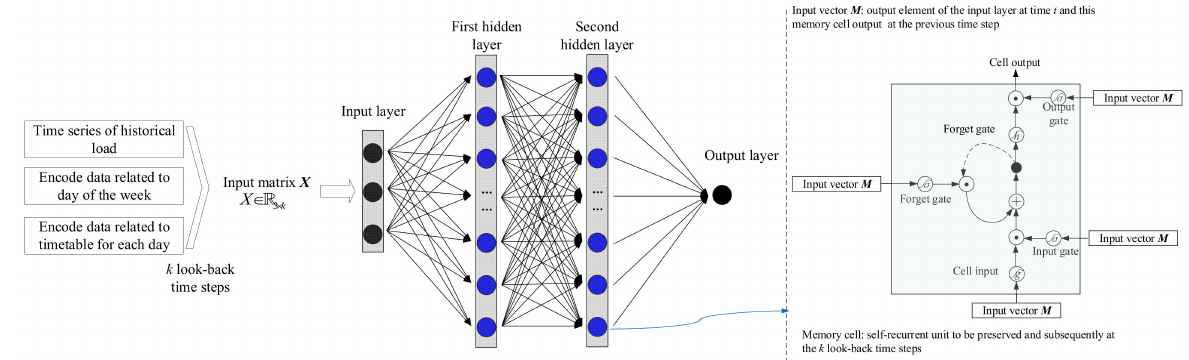
Figure 6. The LSTM-based short-term residential load prediction